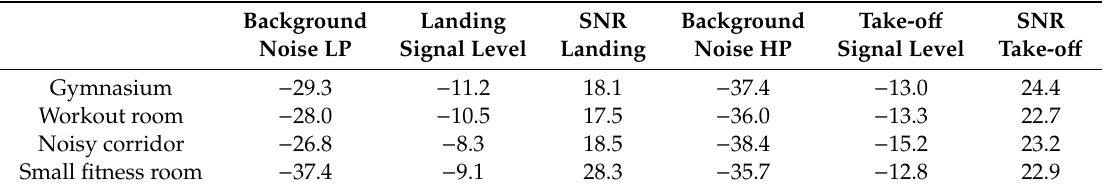
Table 2. Noise levels and signal-to-noise ratios of recording scenarios.